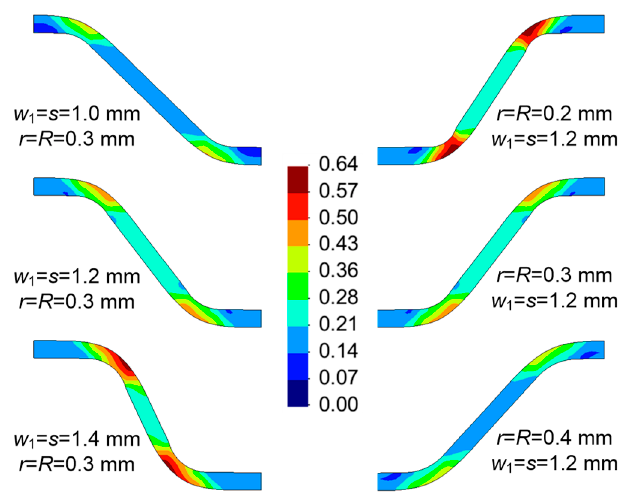
Figure 10. Equivalent plastic strain distribution plotted on the deformed configuration of the channel for three values of channel/rib width (left side) and for three values of punch/die fillet radius (right side) and h = 1.0 mm.